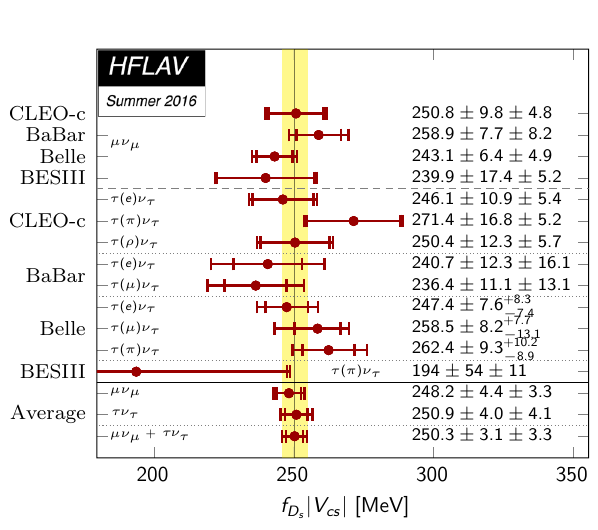
| V | . For each point, the first error listed Fig. 206 WA value for f D cs s is the statistical and the second error is the systematic error matrix elements are those from leptonic and semileptonic D ( s ) decays. The values are in agreement within uncertain- ties with the values obtained from the global fit assuming CKM matrix